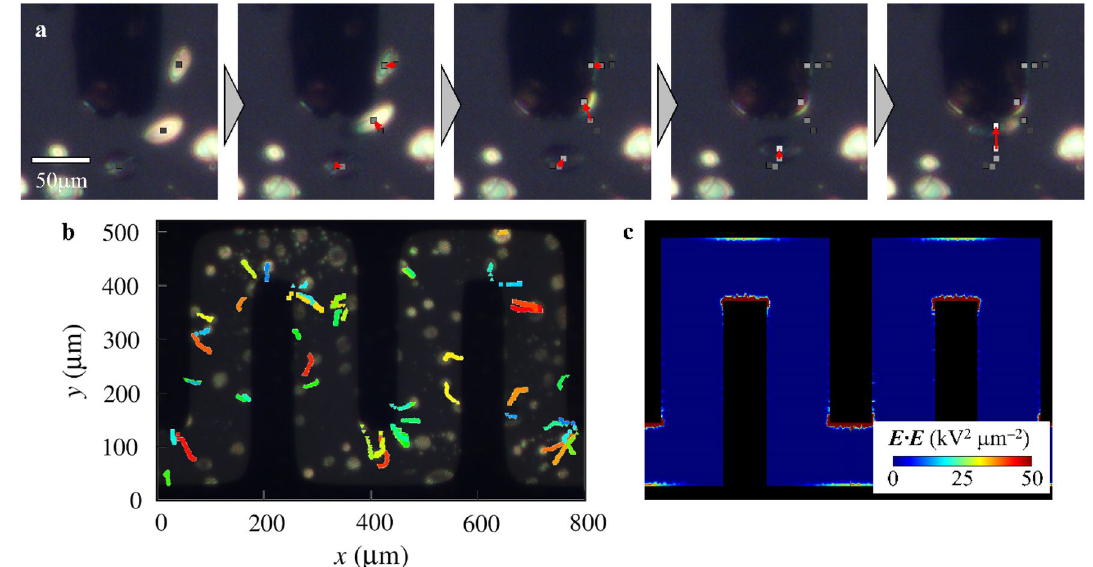
Figure 3. The transportation of LCDs on the microcomb electrodes. (a) POM micrographs of LCDs after voltage application. Images were taken every 1/3 s. Square markers and red arrows indicate the centers of gravity of LCDs and deviation from 1/3 s ago, respectively. (b) Voltage activated transport of LCDs. We obtained the centers of gravity of LCDs every 0.1 s and superimposed the trajectories on a typical POM image. (c) Distribution of electrostatic energy density on the microcomb electrodes from numerical analysis. The color map shows the electrostatic energy